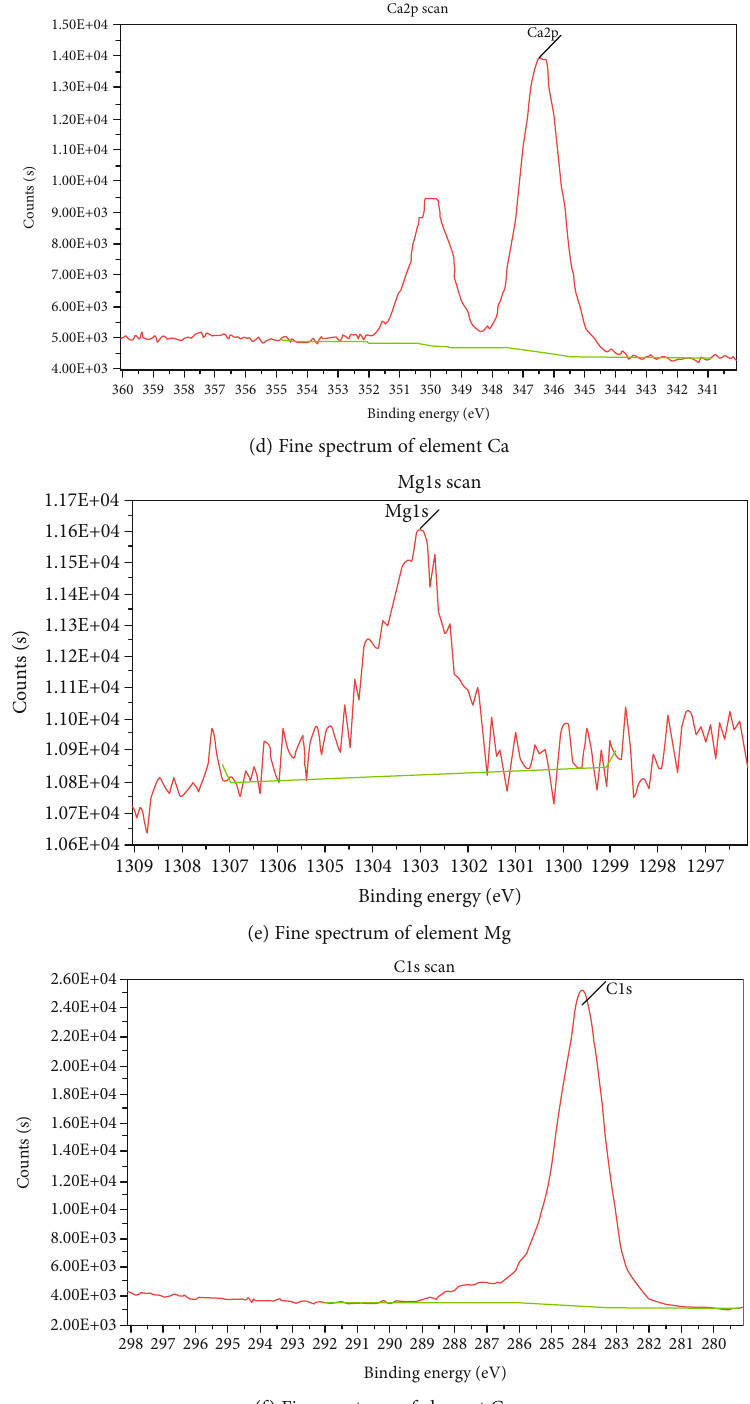
(f) Fine spectrum of element C Figure 6: